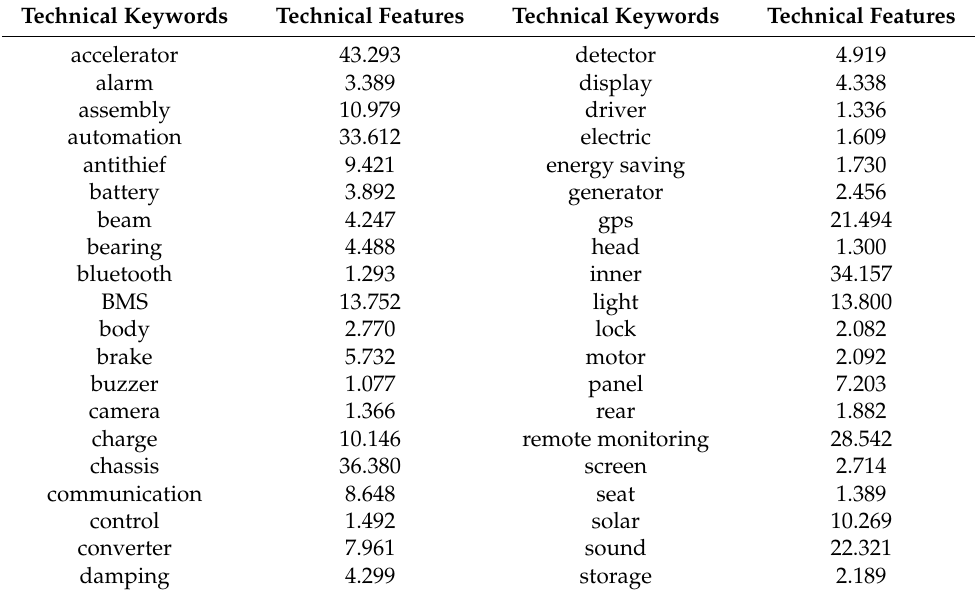
Table 8. Technical features of technical keywords in the EVs field.